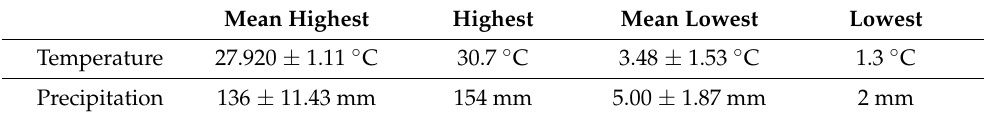
Table 5. Temperature and precipitation limits of Sideritis sipylea as natural adaptations shaping its occurrence in wild Greek habitats. Means were calculated based on thirteen known localities to date in Greece (N =